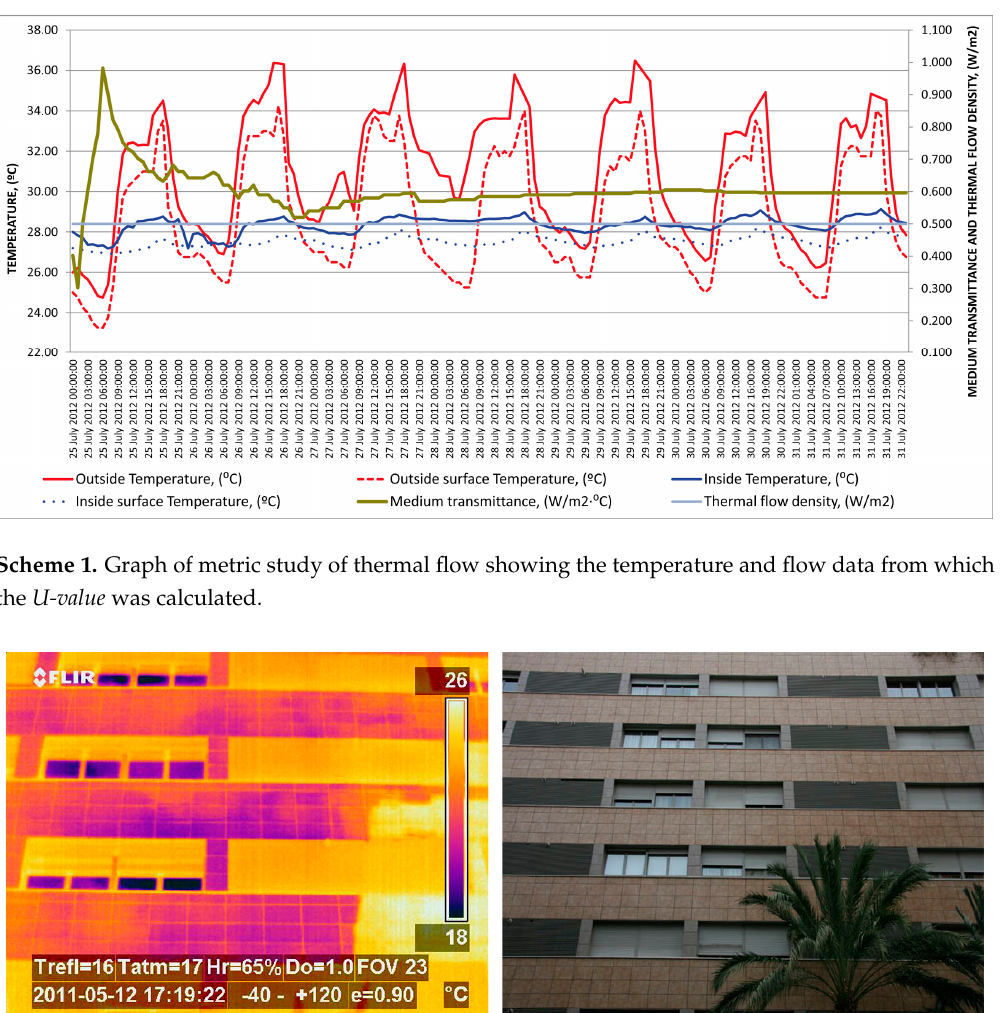
Figure 15. Thermographic picture of the northwest façade. Taken on 12 May 2013 at 3:55 p.m.